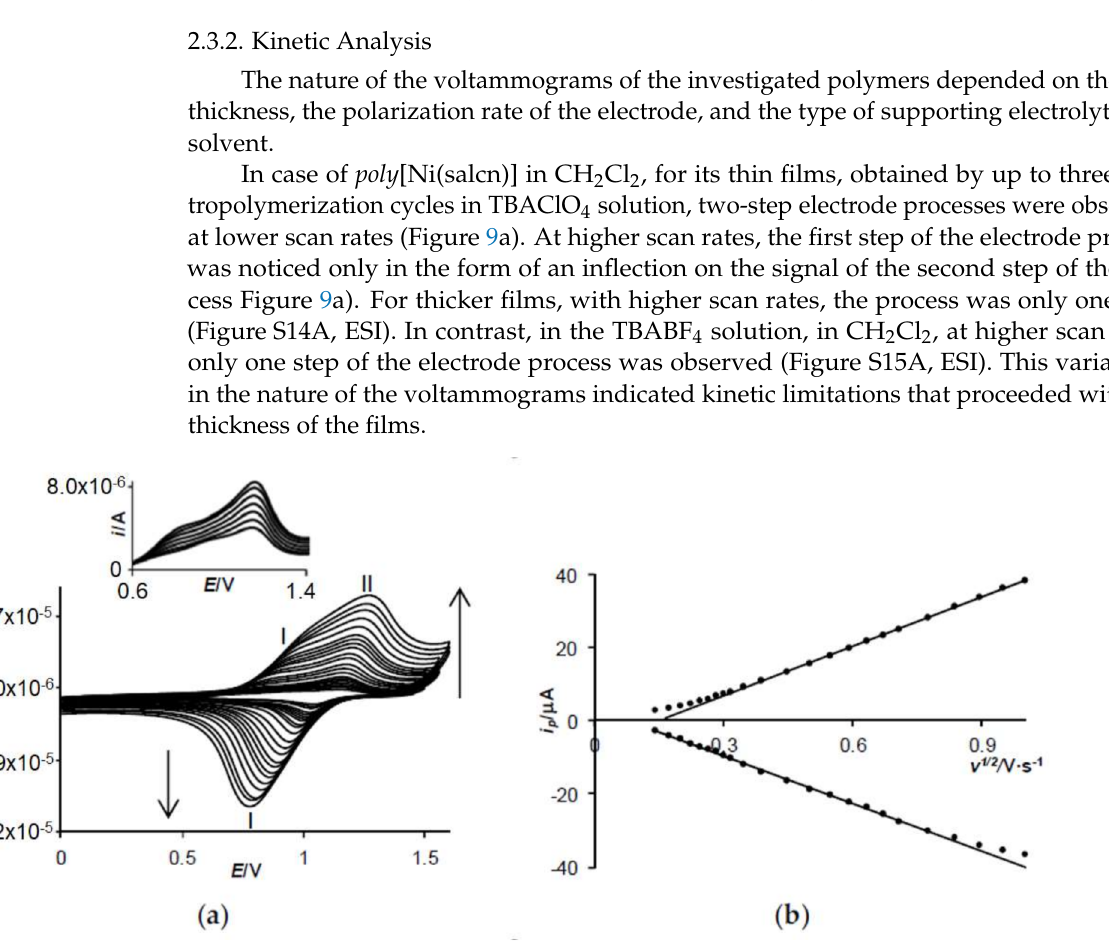
Figure 9. Poly [Ni(salcn)] (3 electropolymerization cycles) in TBAClO 4 /CH 2 Cl 2 , Pt, vs. Ag/AgCl; ( a ) the lower part—cyclic voltammograms for v = 0.02–1 V · s − 1 , the upper part—anodic voltammo- grams for v = 0.02–0.08 V · s − 1 ; ( b ) plots i p vs. v 1/2 for oxidation and reduction processes. I and II—peaks